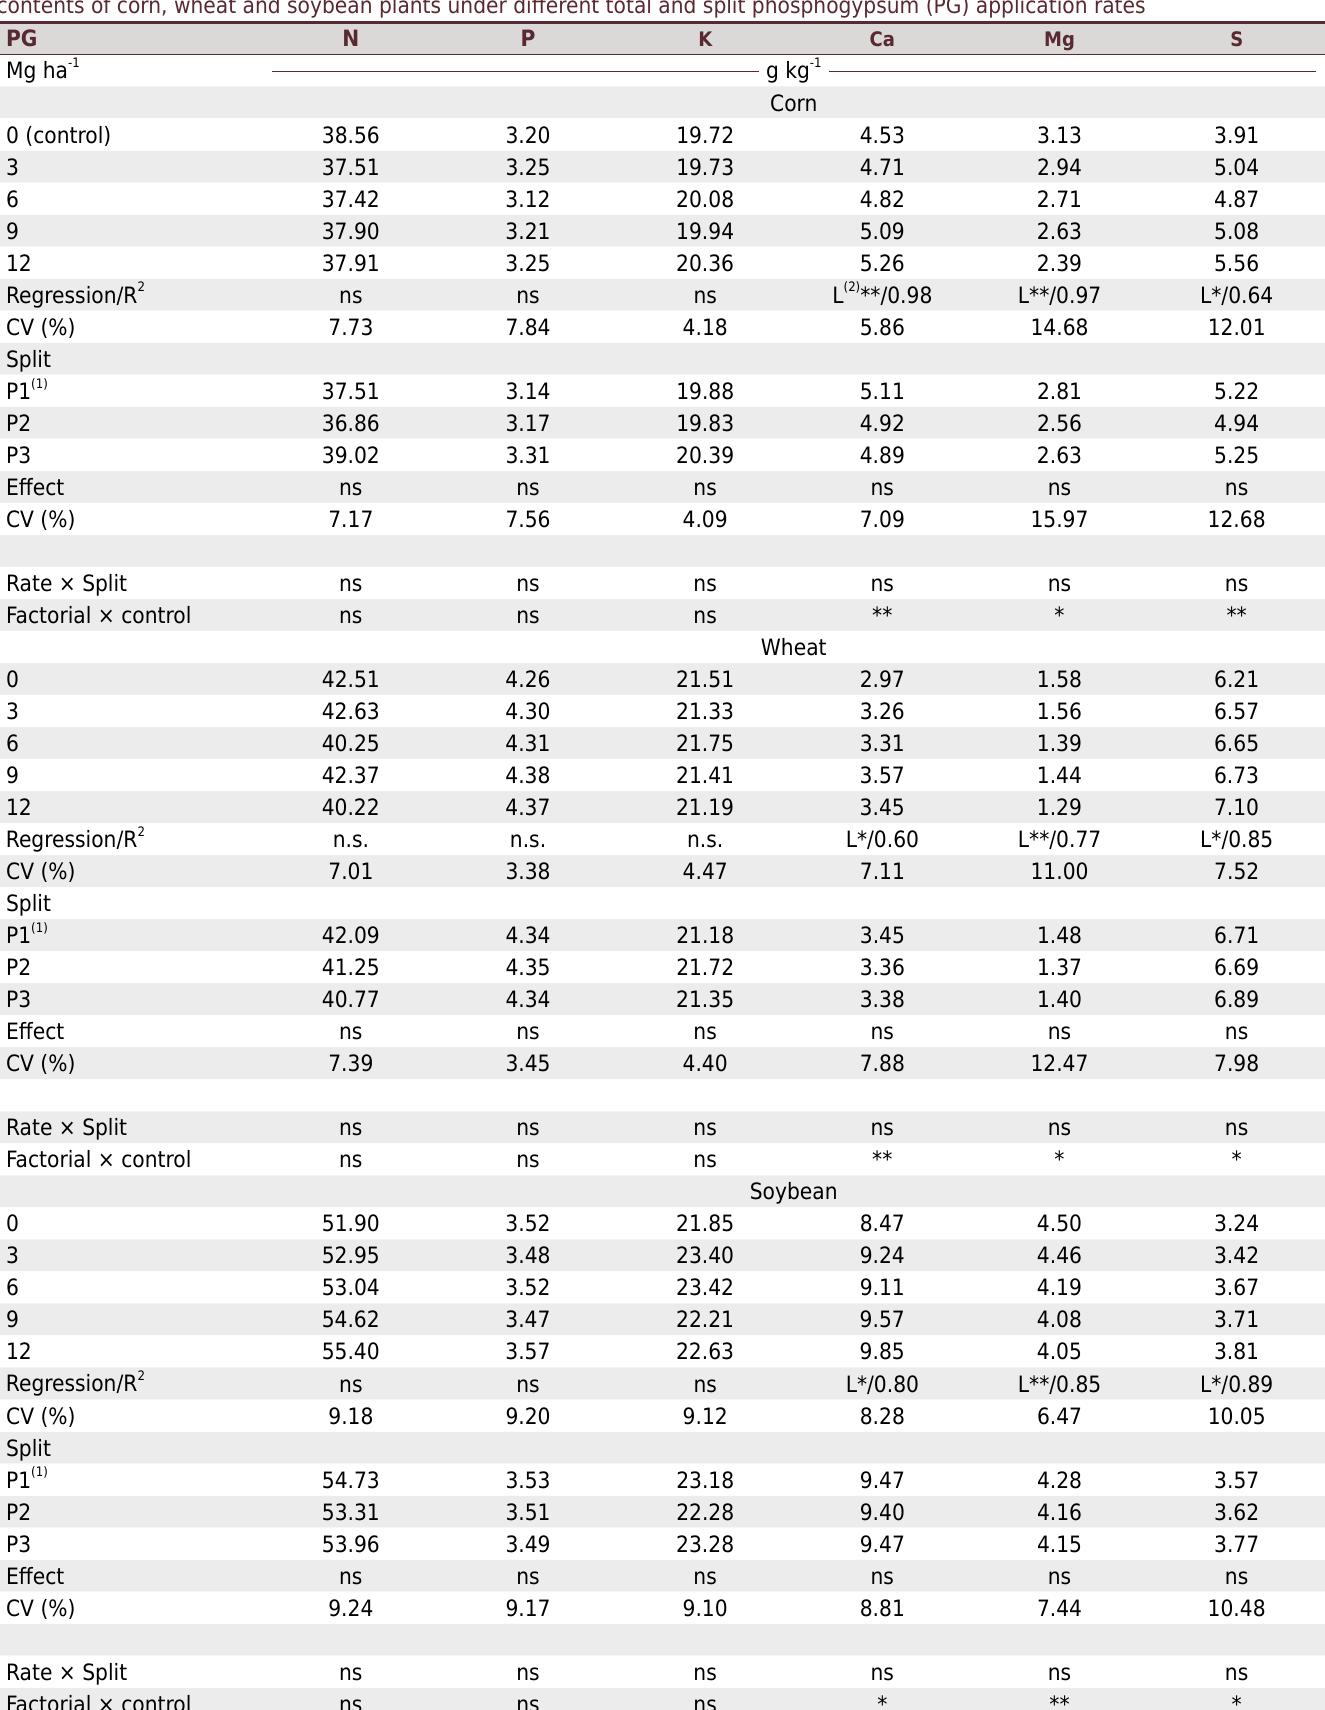
Table 5. Variance and regression analyses, and averages of nitrogen, phosphorus, potassium, calcium, magnesium and sulfur leaf contents of corn, wheat and soybean plants under different total and split phosphogypsum (PG) application